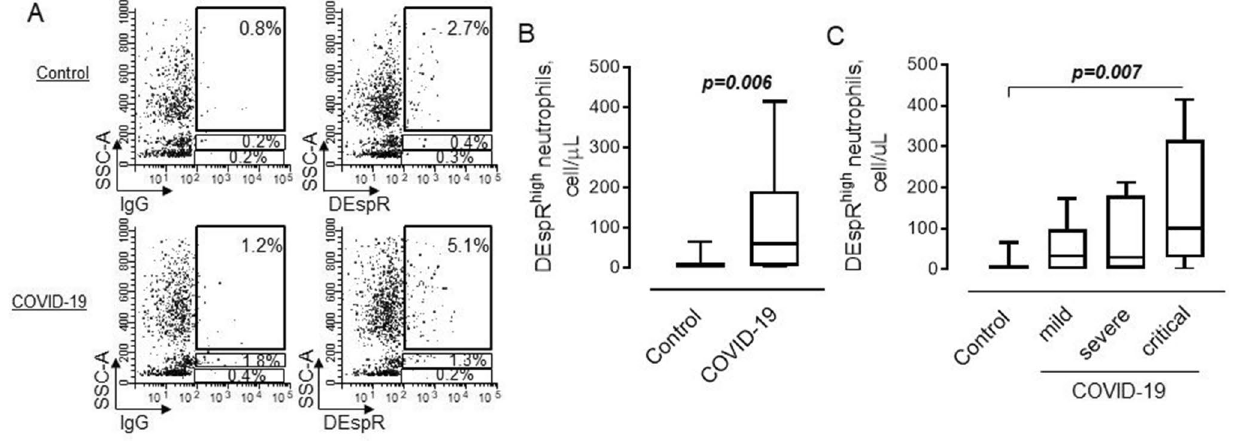
Figure 1. Flow cytometric strategy to determine DEspR high cells in the peripheral circulation. Freshly obtained blood cells were analyzed after erythrocytes lysis. ( A ) Flow cytometric plots showing gating strategy for cells expressing a high level of cell surface DEspR in control (upper) and COVID-19 (lower) subjects. ( B ) Graphical representation of data from flow cytometric analysis on the number of DEspR high /SSC high neutrophils in control ( n = 12) and COVID-19 ( n = 26) patients; Mann–Whitney test. ( C ) The number of DEspR high /SSC high neutrophils in control subjects and patients with mild ( n = 6), severe ( n = 9), or critical ( n = 11) COVID-19. Kruskal–Wallis test, Dunn’s multiple comparisons test; P value is